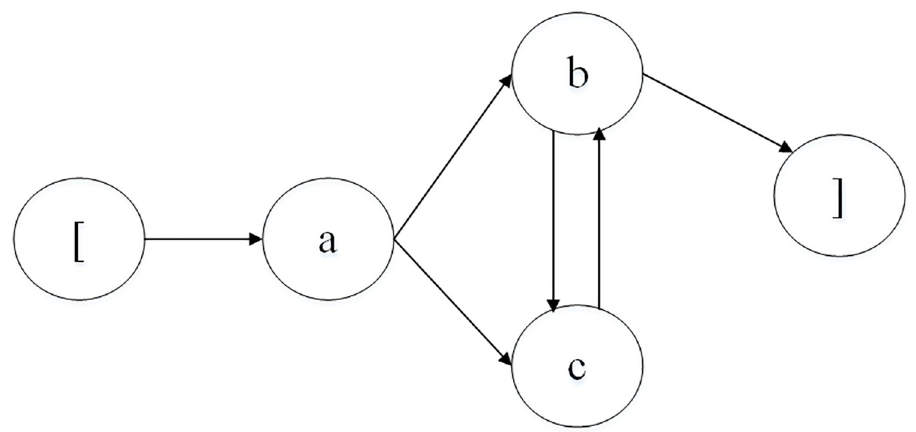
Fig 1. An ESG with pseudo entry and exit